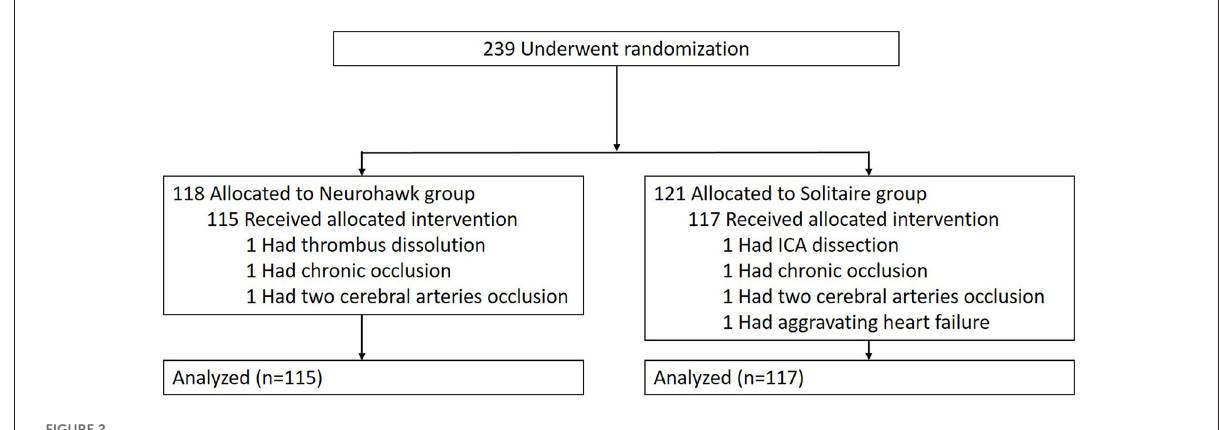
FIGURE2 Randomization and treatment of the